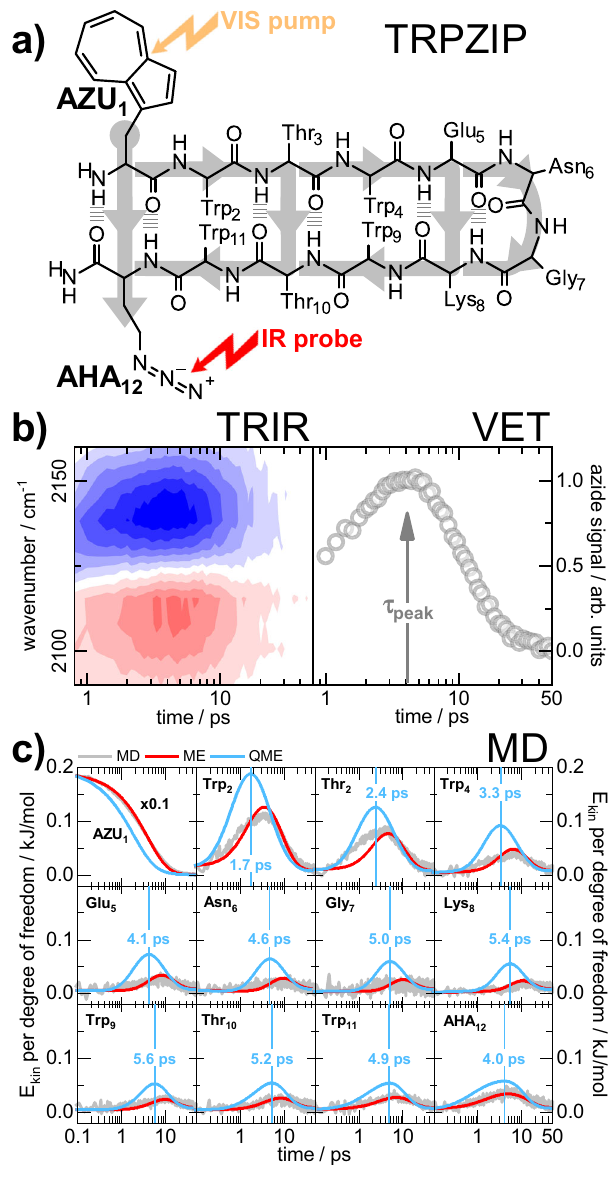
Fig. 1 Principles of our VET study on TrpZip2. a Vibrational energy is injected into the system via Azu and propagates along various possible pathways to Aha (gray arrows). b (Left): TRIR spectrum of the TrpZip2 variant above (the spectra of all variants are shown in Supplementary Fig. 1). The spectral VET signature consists of an induced (red) and reduced (blue) absorption, respectively. The shape is due to the shift of the azide band to lower wavenumbers upon arrival of vibrational energy. (Right) transient of the total absorption change of the VET signal. Arrow indicates the peak time. c Time evolution of residue energies of the variant above obtained from non-equilibrium MD simulations (gray), from the master equation model (ME, red) and from the quantum corrected model (QME, blue). Vertical blue lines indicate the peak times according to the QME model. Source data are provided as a Source Data fi